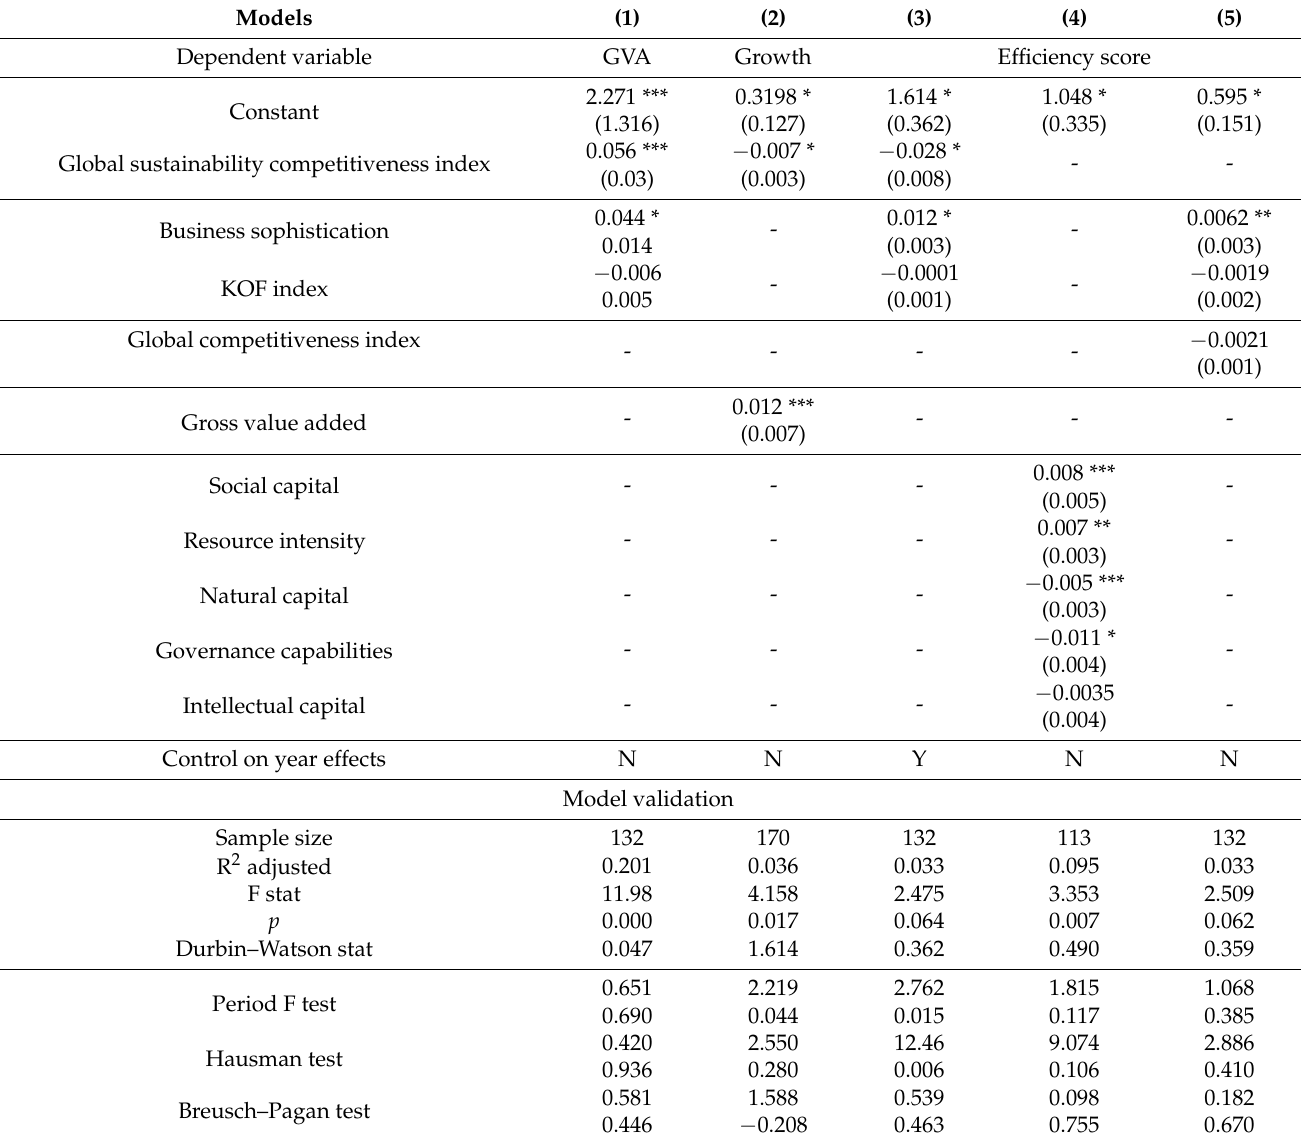
Table 4. OLS estimated econometric